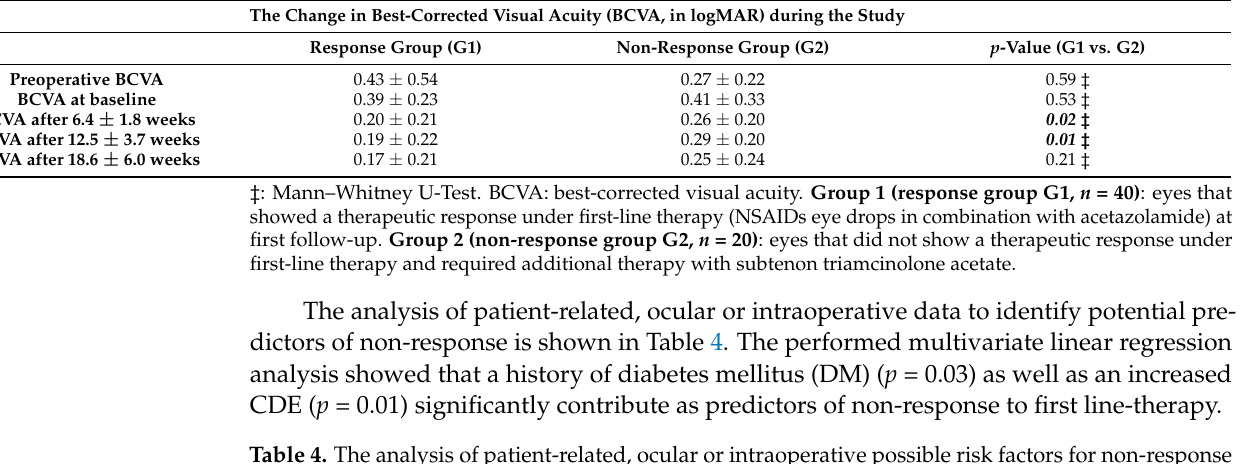
Table 4. The analysis of patient-related, ocular or intraoperative possible risk factors for non-response to therapy with NSAID eye drops and